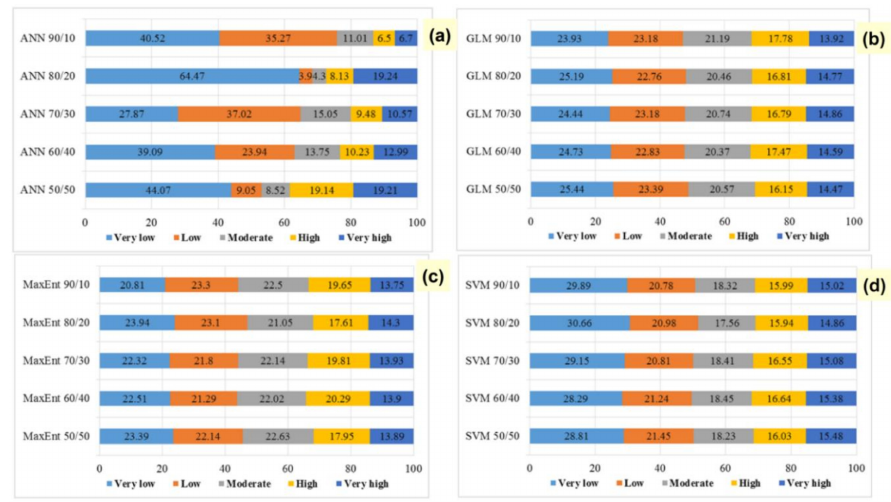
Figure 9. Area percent classes in the ANN ( a ), GLM ( b ), MaxEnt ( c ), and SVM ( d )